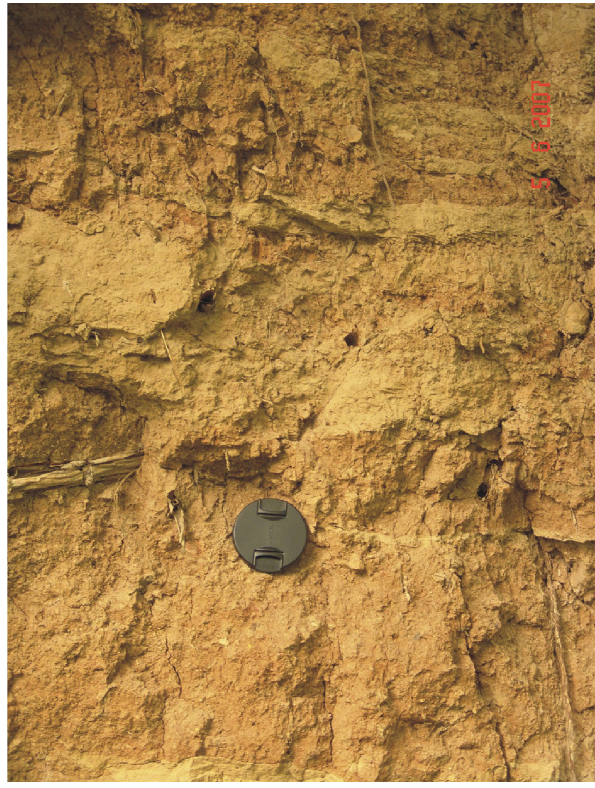
Fig. 5. Shear zone of the Zhuyuan